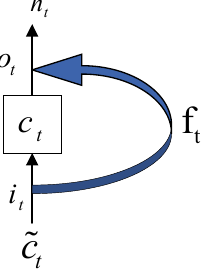
Figure 5. Basic structure of LSTM.